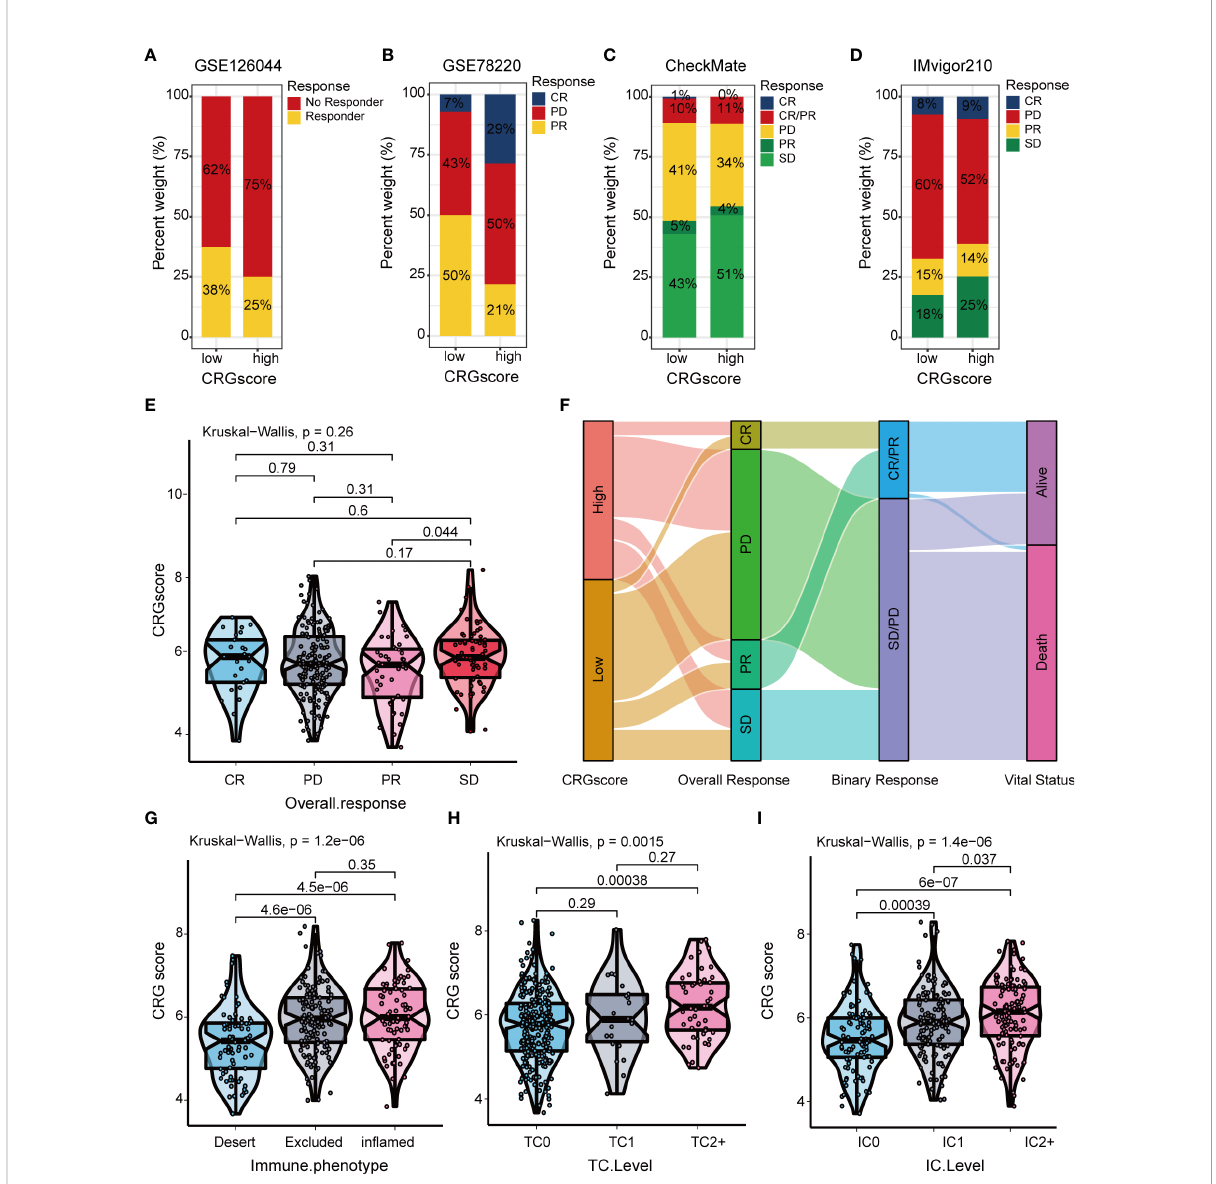
FIGURE 11 Correlation of the CRG score with immunotherapy response in mutiple cohorts. The distribution of immunotherapy response in indicated groups strati fi ed by CRG scores in (A) GSE126044, (B) GSE78220, (C) the CheckMate cohort, and (D) the IMvigor210 cohort. (E) Difference in CRG scores among four immunotherapy response groups in the IMvigor210 cohort. (F) Sankey diagram of subtype distributions in groups with different CRG scores and immunotherapy response in the IMvigor210 cohort. Differences in the CRG score among (G) three immune phenotypes, (H) three TC levels, and (I) three immune cell (IC) levels in the IMvigor210 cohort. CRGs, cuproptosis-related genes; TC, tumor cell; IC, immune